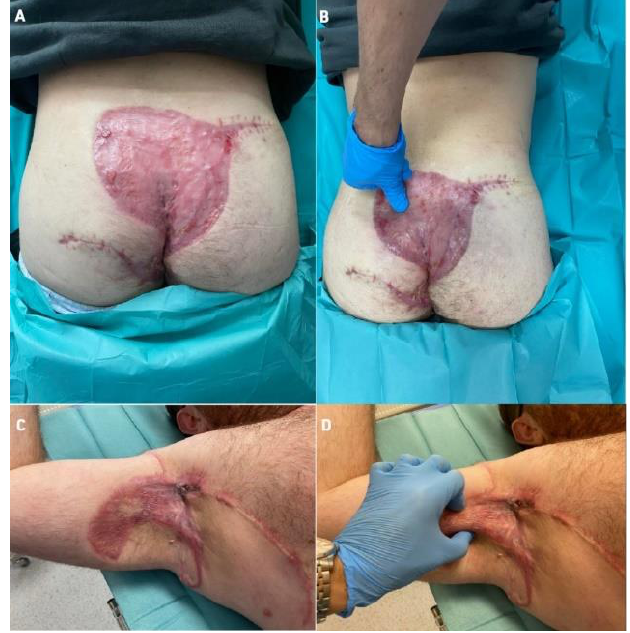
Figure 9. Final results 2.5 month after procedure co-graft of ADM and STSG. ( A ) — Final result of reconstructed bottocks, ( B ) —Elastic scar in the “pinch” test, ( C ) — Final result of reconstructed right axilla, ( D )—“Pinch” test in right axilla (elastic scar). Legend: ADM—Acellular Dermal Matrix, STSG—Split thickness skin graft.